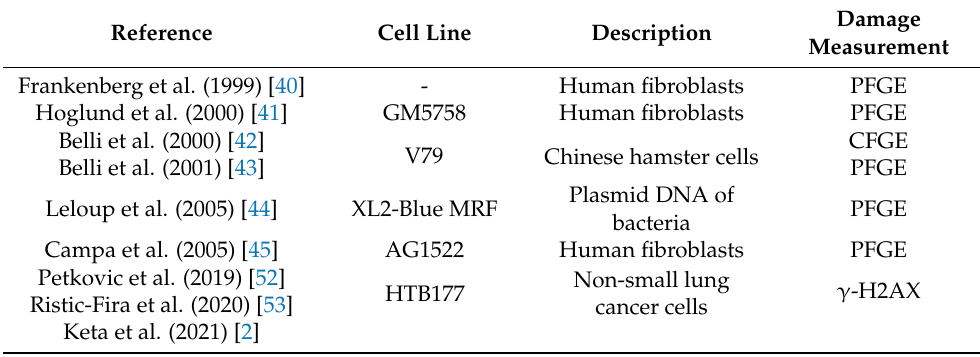
Table 2. The experimental data and corresponding references, cell lines, cell types, and approaches used for measuring